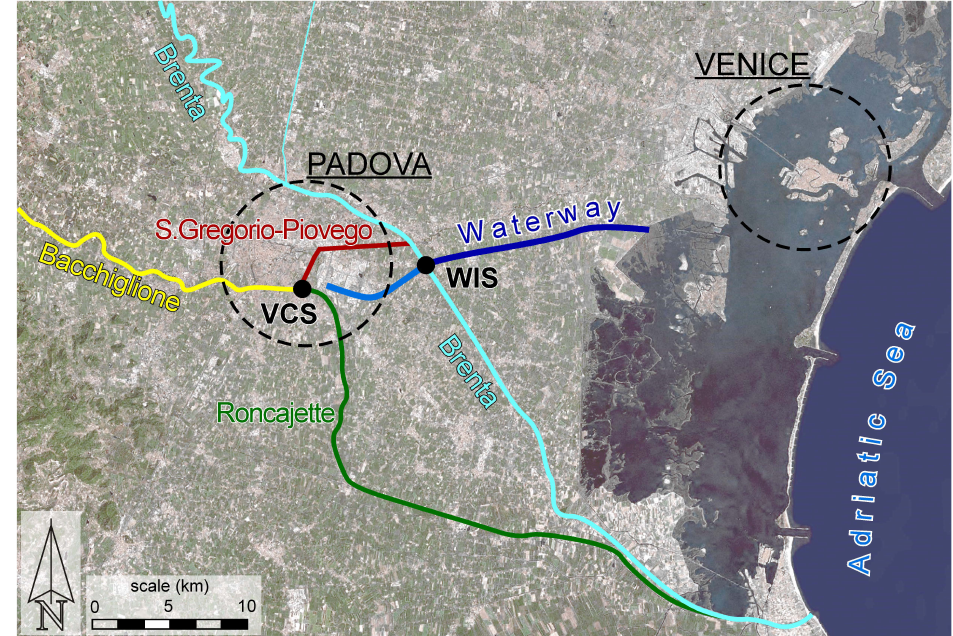
Figure 1. The Brenta–Bacchiglione river network from Padova to the Adriatic Sea. The yellow line represents the Bacchiglione River; the green line is the Roncajette River, which originates from the Voltabarozzo control structure (VCS); the cyan line is the Brenta River, with its lowland tributary, the Muson dei Sassi River; the blue line is the Waterway Padova–Venice (in light blue the segment already built, in dark blue the segment that is still to be completed). The black points represent the Voltabarozzo control structure (VCS) and the waterway intake structure